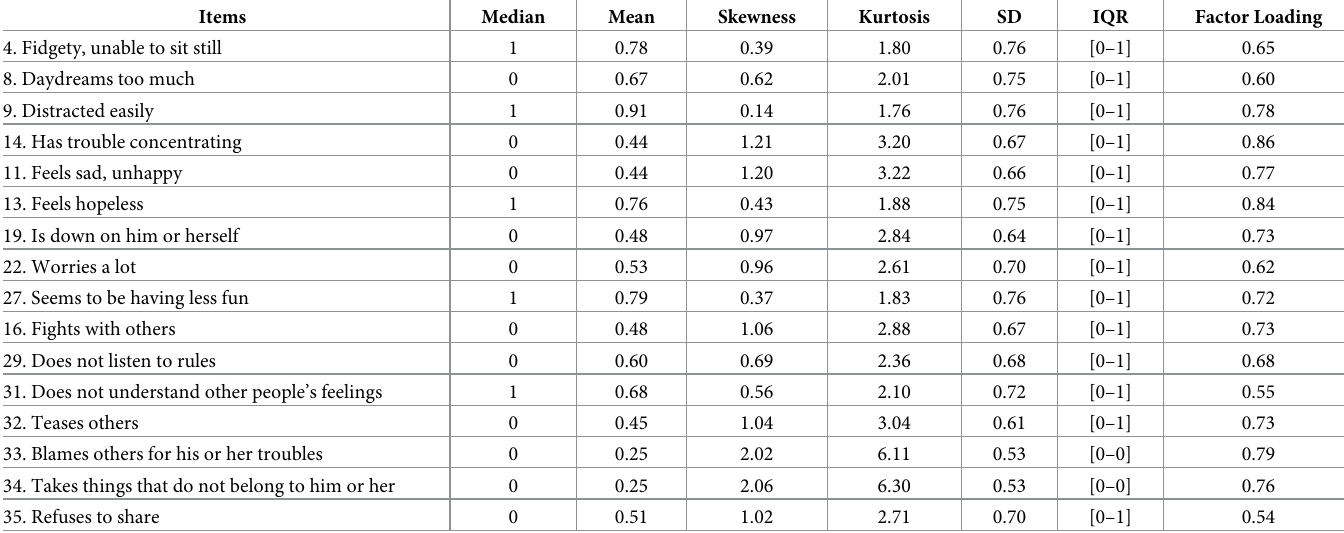
Table 3. Descriptive Statistics and factor loading of the PSC-16-Y items.